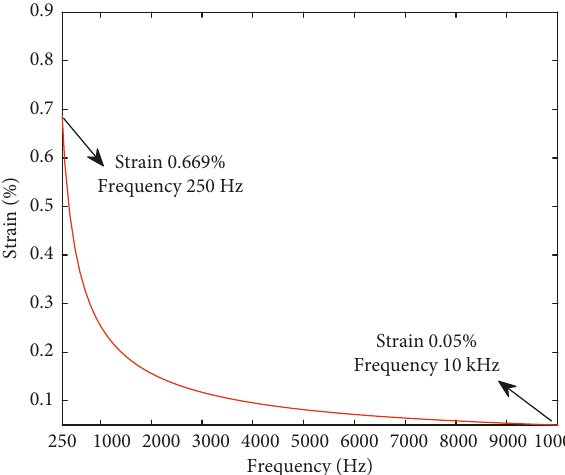
Figure 10: The working window of the new DMA system.